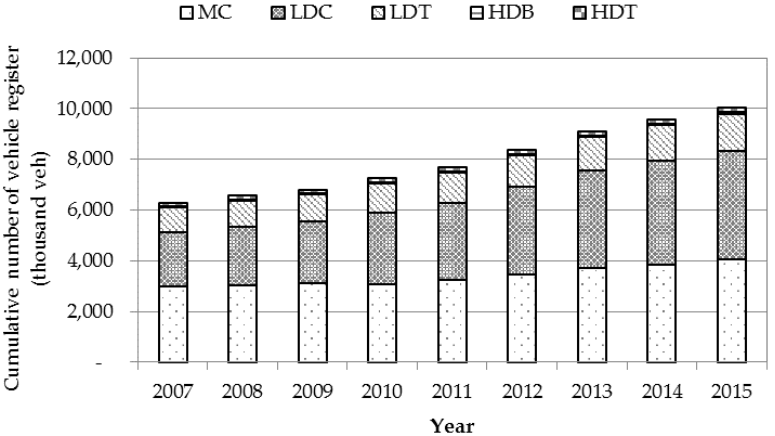
Figure 4. Cumulative number of vehicles registered in the BMR area from 2007–2015. Remark: MC stands for motorcycles; LDC stands for light duty cars (including passenger cars less than seven seats and passenger cars over seven seats); LDT stands for light duty trucks; HDB stands for heavy duty trucks (including non-fixed route and private trucks).